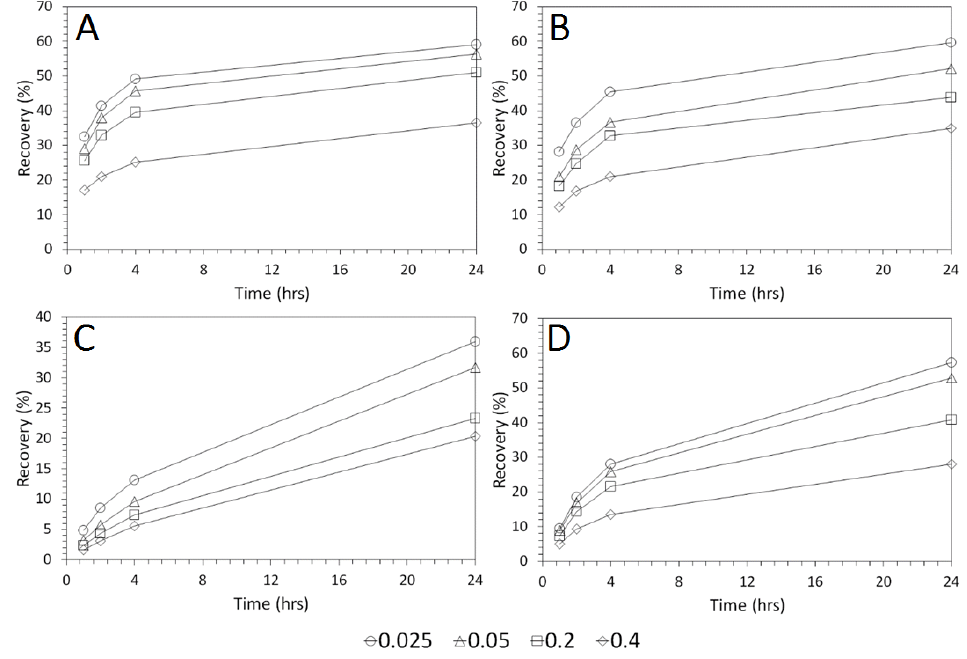
Figure 9. As recovery as a function of time for solid – liquid ratios of 0.025, 0.05, 0.2, and 0.4 using: H 2 SO 4 ( A ), HCl ( B ), C 6 H 8 O 7 ( C ) and CH 3 SO 3 H ( D ). The acid concentrations were 1 M and the lixiviant volumes were 200 mL.